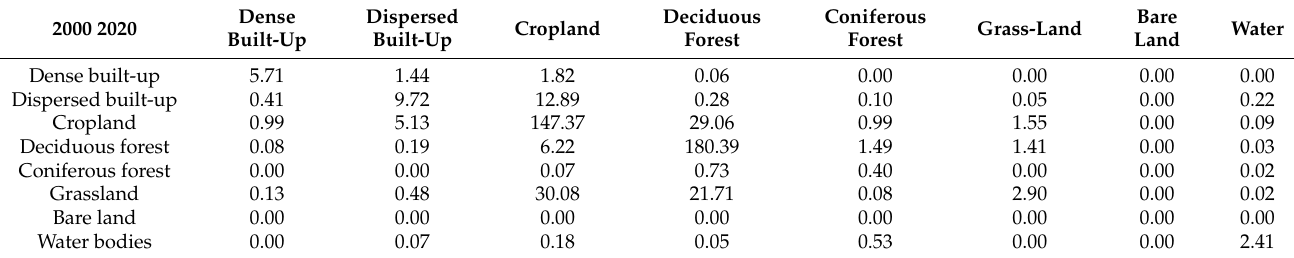
Table A3. Land cover area transfer matrix for Velika Gorica from 2000 to 2020 (km 2 ).